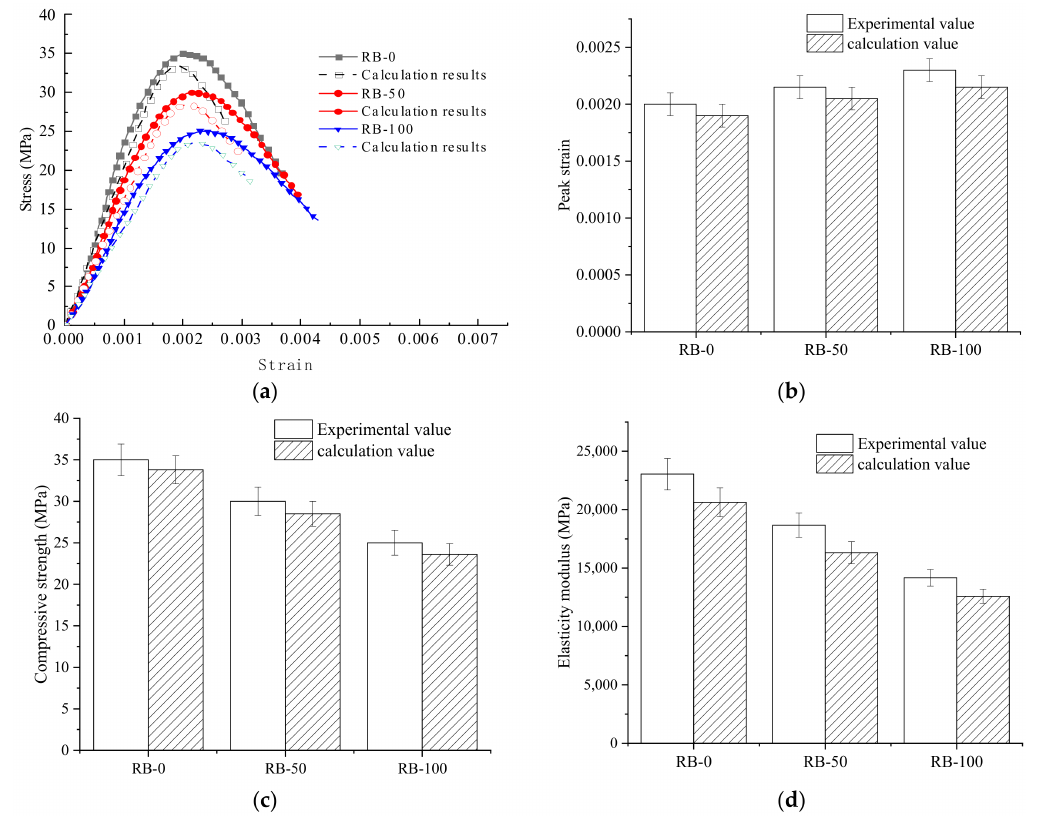
Figure 11. Comparison between numerical simulation and test results: ( a ) stress–strain curve, ( b ) histogram of peak strain, ( c ) histogram of compressive strength, ( d ) histogram of elastic modulus.